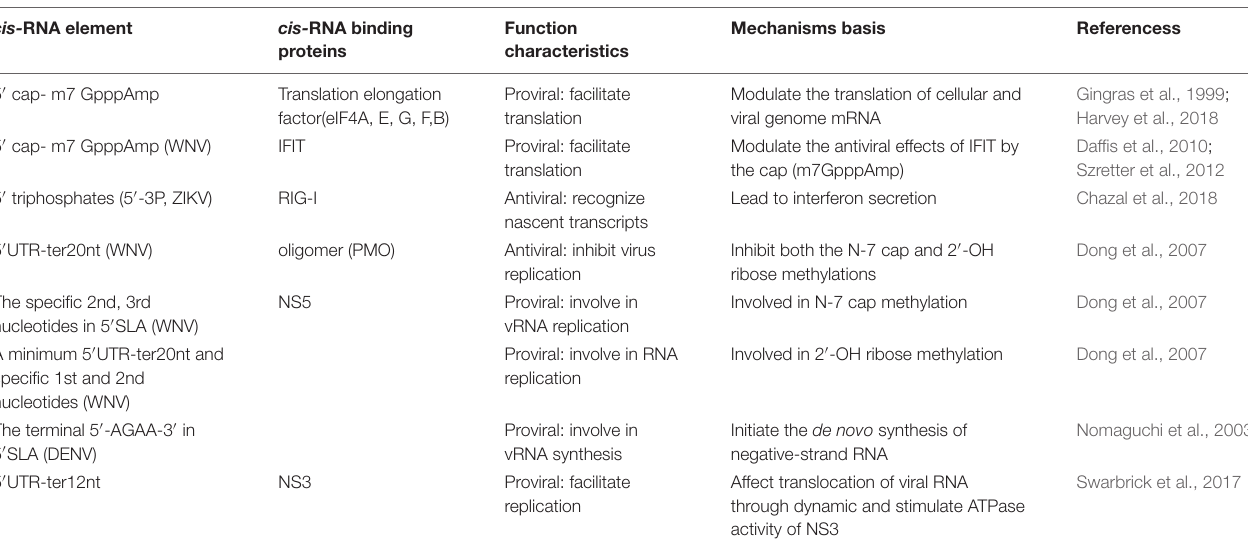
TABLE 2 | Terminal 5 (cid:48) cis- acting RNAs and the binding proteins involved in MBFV life cycle. cis- RNA element cis- RNA binding Function proteins